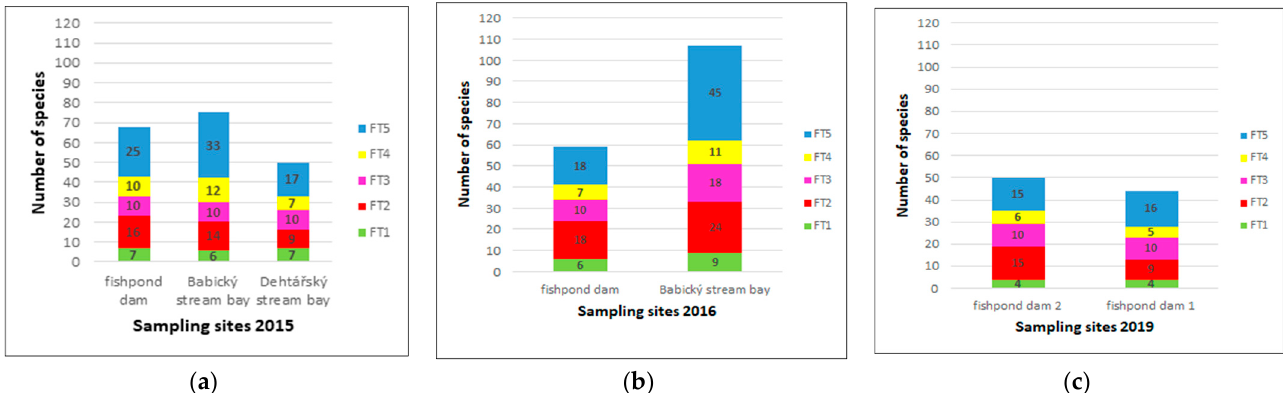
Figure 10. Diatom species numbers and representation of five diatom functional groups (FT1–FT5) in the species pool of sampling sites in the Dehtá ř fishpond. ( a ) Year 2015; ( b ) Year 2016; ( c ) Year 2019—only FD was sampled but two different microsites were included (fishpond dam 1 = site 1, fishpond dam 2 = site 2; see Table S3 for more